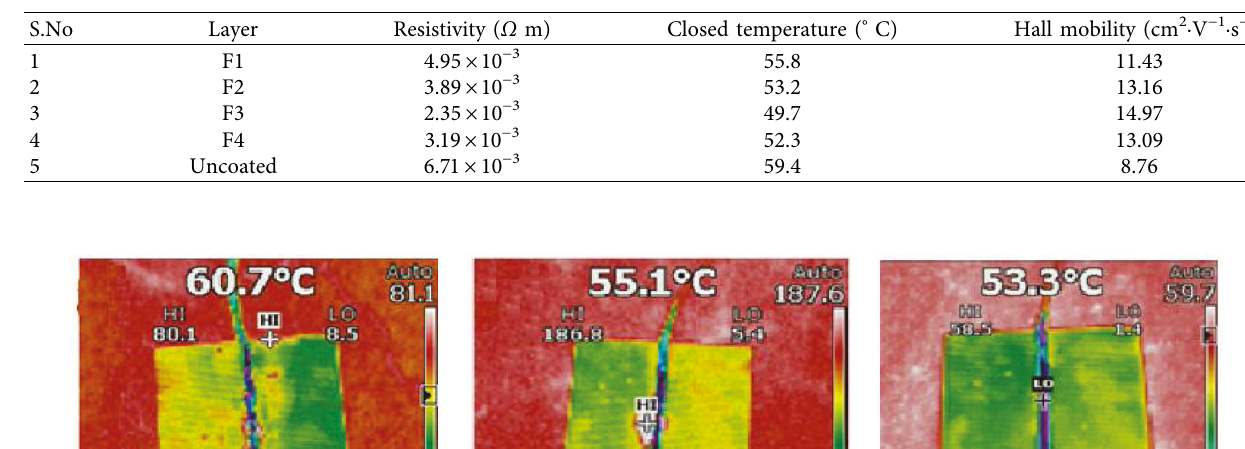
Table 4: Electrical resistivity and hall mobility of various coated samples.